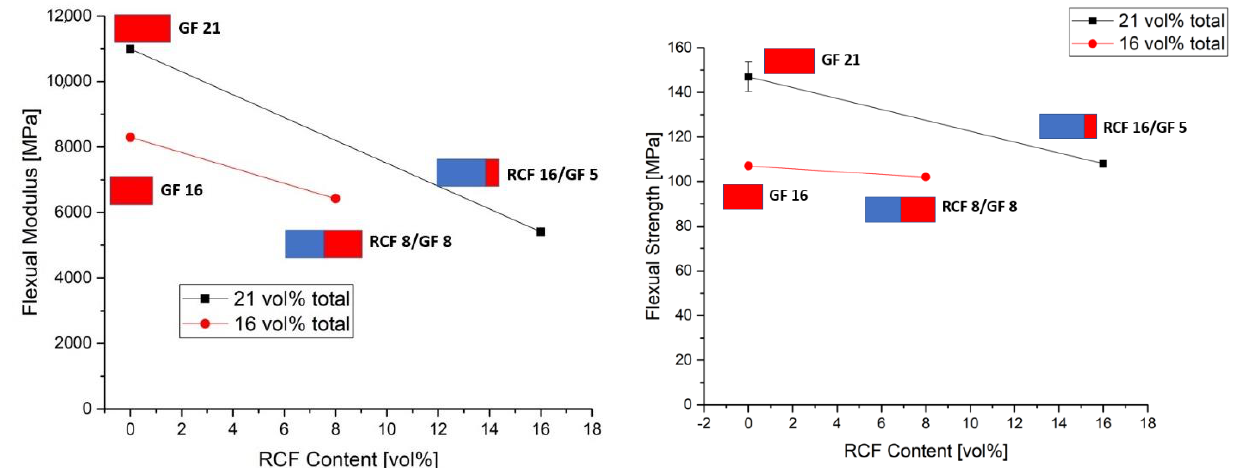
Figure 4. Flexual modulus ( left ) and strength ( right ) of 16 and 21 vol% fibers with different ratios of GF/RCF and GF reference compounds.